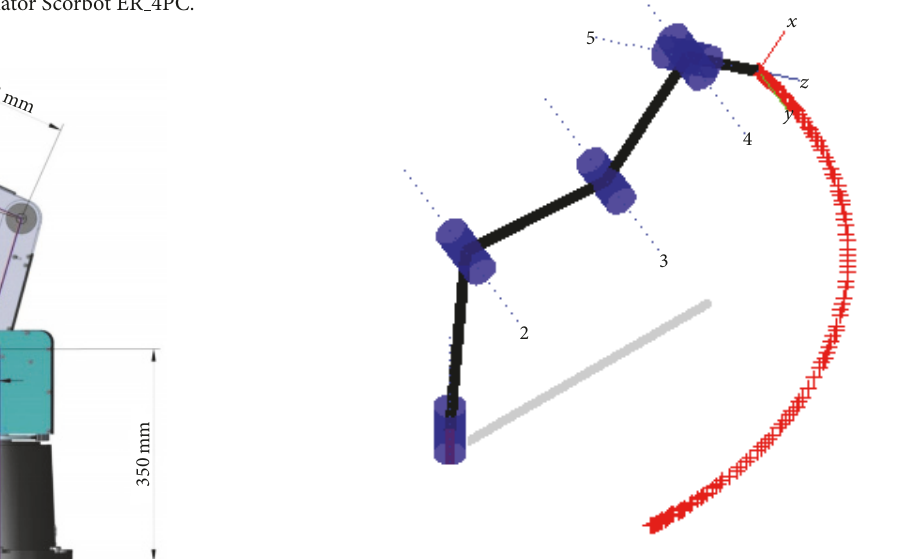
Figure 4: Simulation of movement